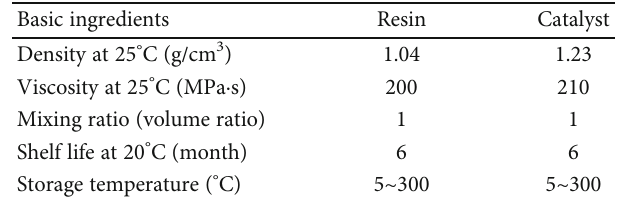
Figure 17: Plastic damage. Table 6: Malisan N basic data. Table 7: Malisan N performance